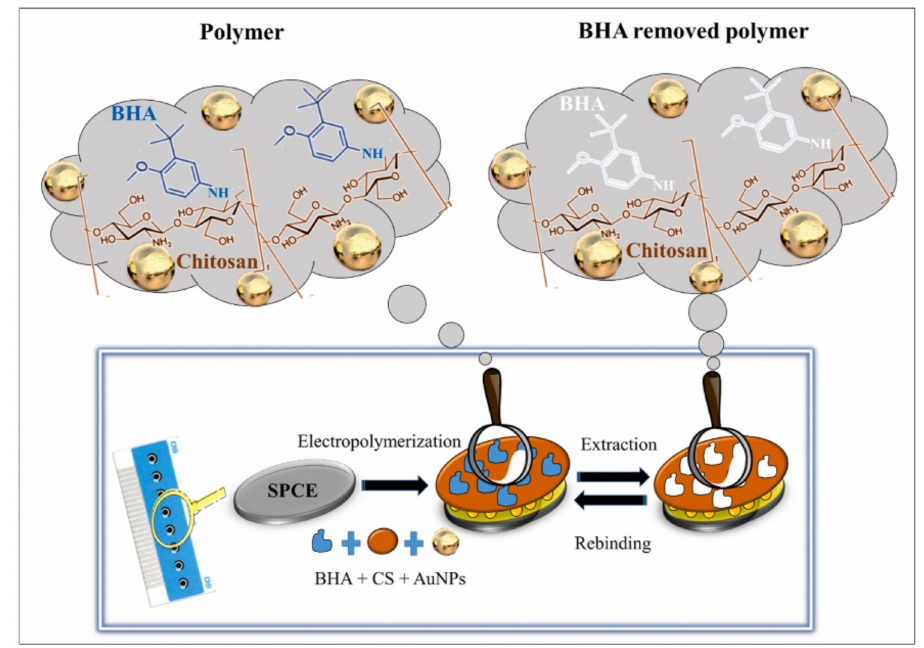
Figure 12. Scheme of the molecular architecture of the BHA-imprinted sensor. Reprinted with the permission from reference [128]. Copyright 2021 Elsevier. Table 6 summarizes the examples of CHI-based sensors for the determination of contaminants and additives. Table 6. Recent examples of CHI-based electrochemical (bio)sensors for contaminants and additives detection.